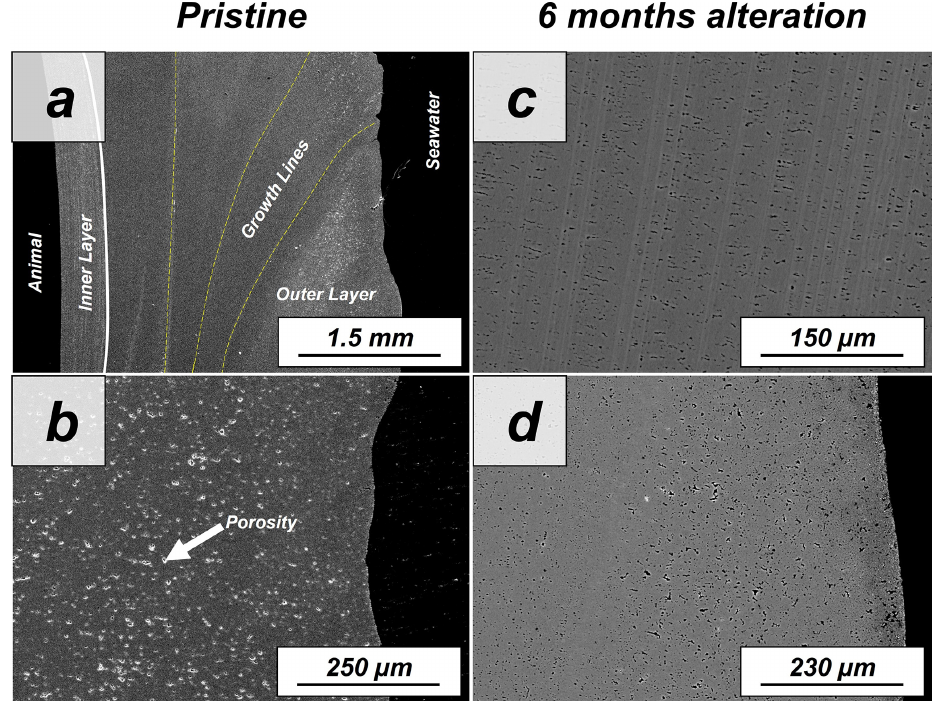
Figure A5. FE-SEM images of (a, b) pristine and (c, d) altered shells of the bivalve Arctica islandica . The shell consists of an assemblage of irregular aragonite crystals embedded in a network of biopolymer fibres (this study and Casella et al., 2017, 2018). Two layers comprise the shell, both with abundant pores and growth lines (c, d) . Hydrothermal alteration at 80 ◦ C in a burial-mimicking fluid for 4 and 6 months does not inflict significant shell structure reorganization and change that can be observed with FE-SEM imaging.